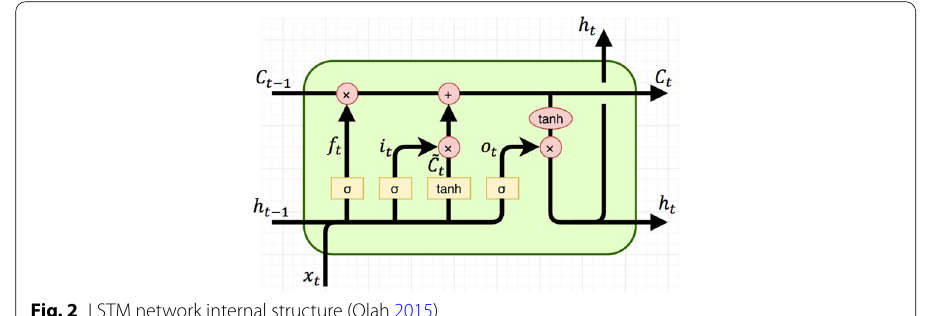
Fig. 2 LSTM network internal structure (Olah